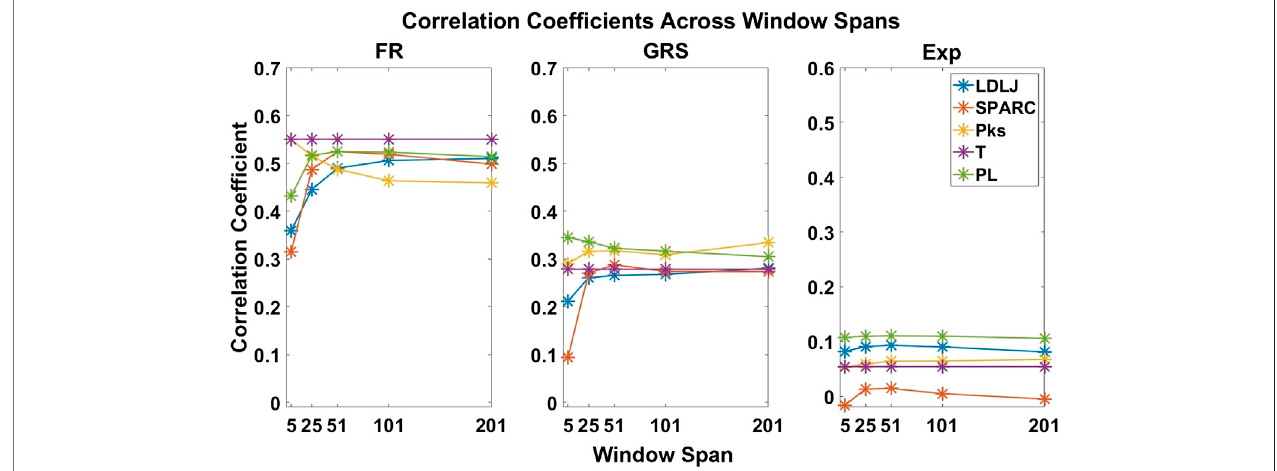
FIGURE7| Correlationcoefficientsofeachprocessmetricwithrespecttoeachskillindicatormetric.Thecoef fi cientsareplottedacrossallwindowspans.Thisplot demonstrates the effect of the degree of smoothing on the strength of association between process and skill indicator metrics.